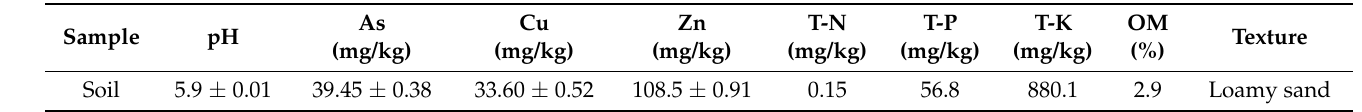
Table 2. Physicochemical properties of the initial soil.